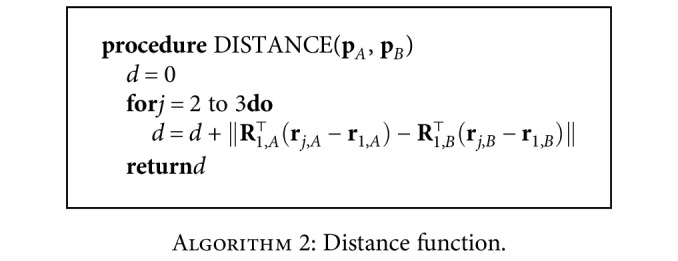
 Distance function.